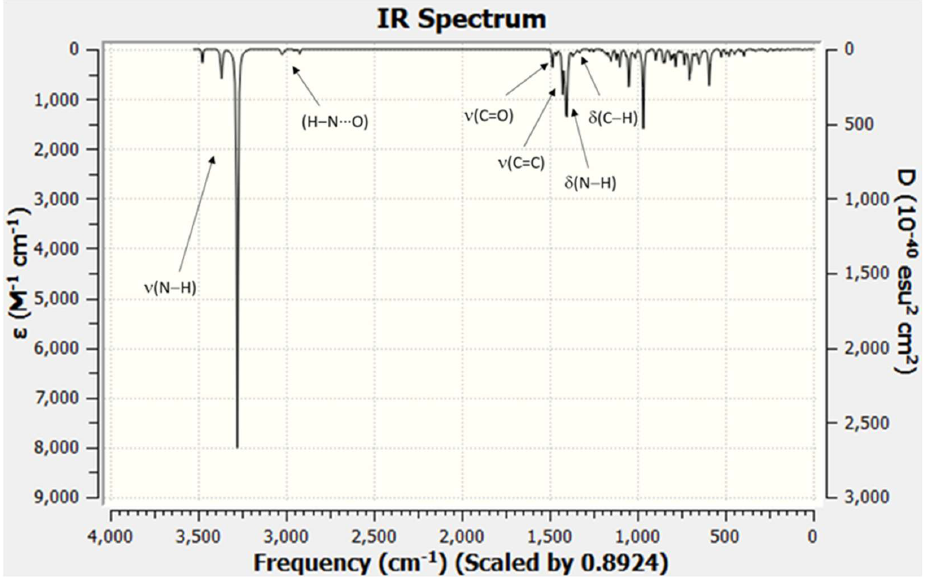
Figure 13. Simulated FTIR spectrum of (Bar–CLA) by DFT.